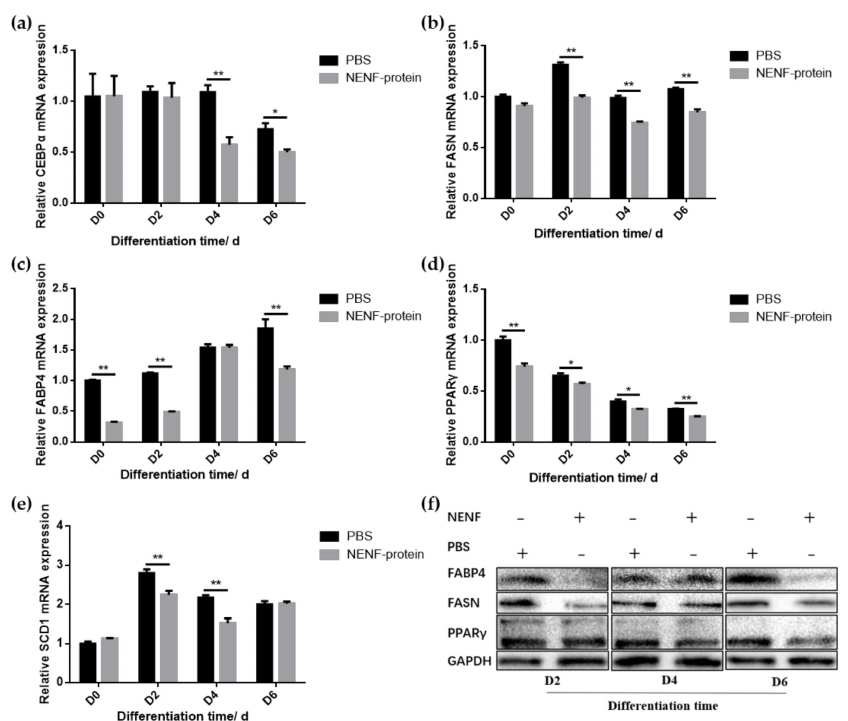
Figure 4. Detection of the expression of adipocyte differentiation marker gene at the mRNA and protein levels. ( a–e ) The expression of lipid-related factors CEBP α , FASN , FABP4 , PPAR γ and SCD1 at the mRNA level after adding the recombinant protein NENF and PBS at 0th day of natural differentiation (D0), 2nd day of natural differentiation (D2), 4th day of natural differentiation (D4) and 6th day of natural differentiation (D6); ( f ) Western blot results of FABP4, FASN and PPAR γ protein expression levels after adding the recombinant protein NENF and PBS at 2nd day of natural differentiation (D2), 4th day of natural differentiation (D4) and 6th day of natural differentiation (D6). Error bars represent s.e.m. * p < 0.05; ** p < 0.01.